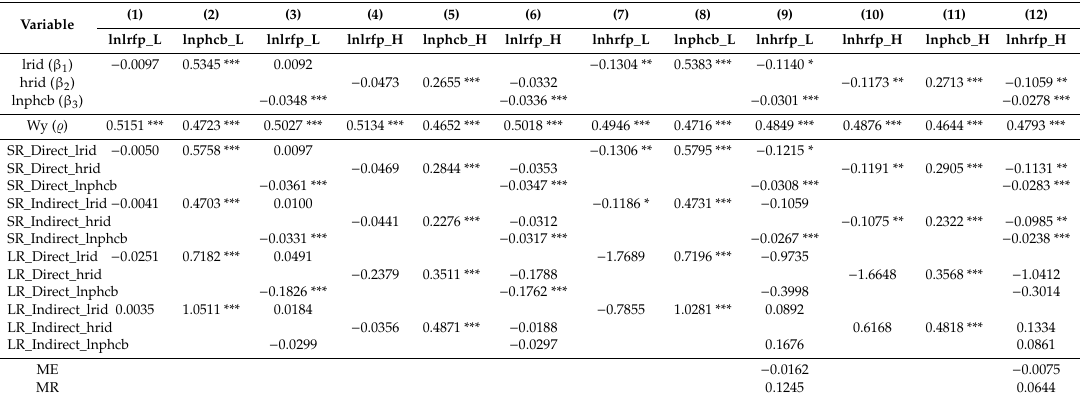
Table 6. Further Analysis of heterogeneous food price risk mediation.